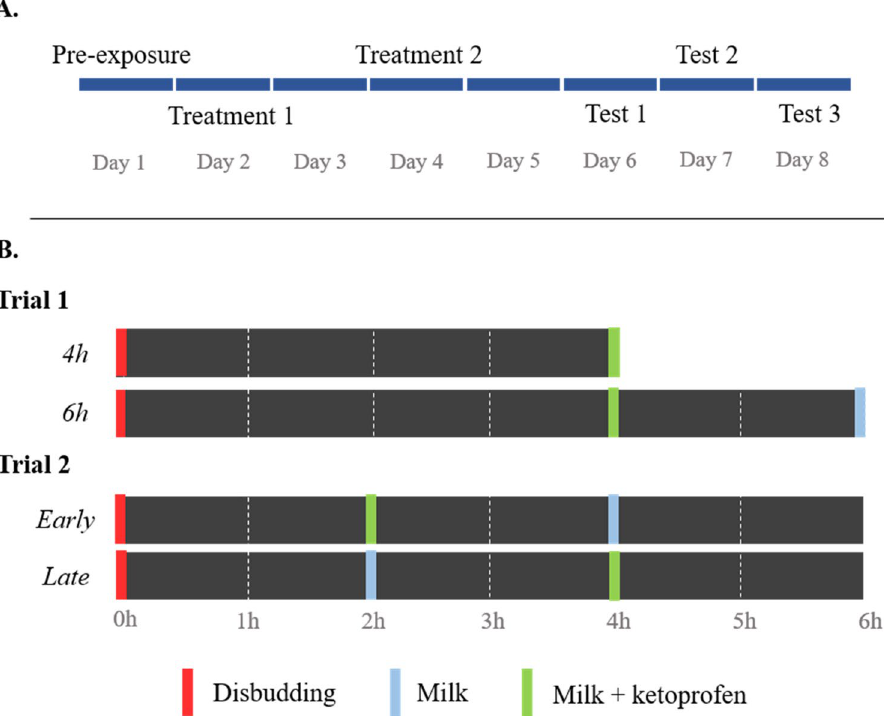
Figure 4. For both trials, calves received two conditioning sessions (‘Treatment 1 and 2’, Fig. 2A): one where an analgesic (ketoprofen) was provided towards the end of the experience, and one without. Calves were then tested three days in a row for place aversion. For trial 1, calves were left for an additional 2 h in the conditioning pen following ketoprofen treatment. For trial 2, calves received ketoprofen 4 h after disbudding instead of 2